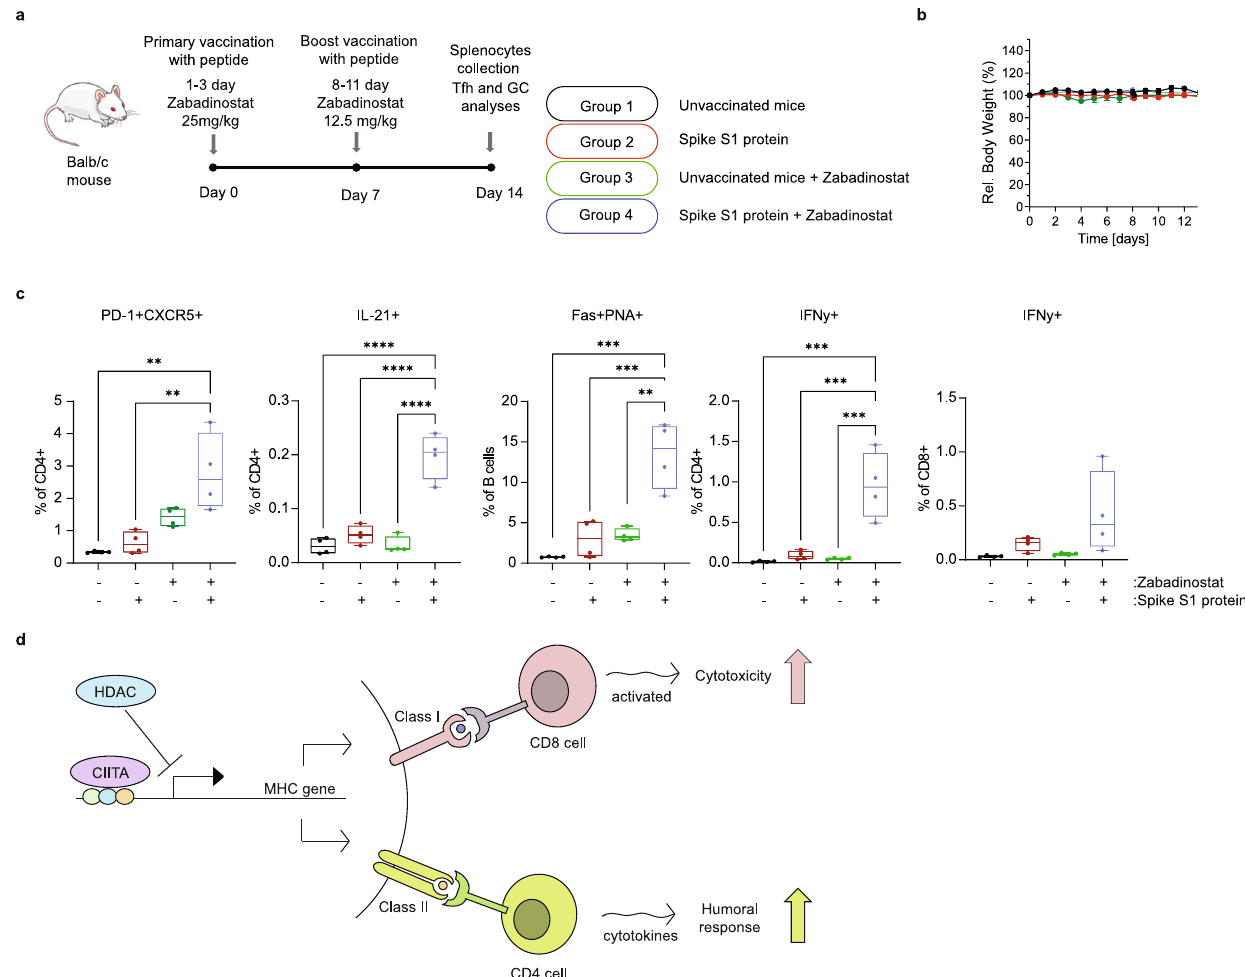
Fig. 7 Zabadinostat augments the level of GC B cells through modulating the activity of Tfh cells. a Schematic representation of the immunogenicity experiment with zabadinostat and spike S1 protein. Balb/c mice were treated with orally administrated zabadinostat at 25 mg/kg (days 1 – 3) or 12.5 mg/kg (days 8 – 11), and intravenous spike S1 protein (10 µ g) (days 0 and 7) with respect to vehicle-only control; splenocytes were collected at day 14; b relative body weight representation of treated and non-treated mice; n = 4; results presented as mean values + / − SD; c follicular T-cell level (CD4 + PD- 1 + CXCR5 + positive T cells), germinal centre B cells (Fas + PNA + positive B cells) and intracellular cytokine IL-21 (in CD4-positive T cells), IFNy (in CD4 and CD8-positive T cells) secretion measurements by fl ow cytometry; n = 4; results presented as mean values + / − SD; one-way ANOVA. d Model describing the effect of zabadinostat in regulating the adaptive immune response. It is proposed that inhibition of histone deacetylase induces both cellular and humoral immune responses by increasing antigen presentation (e.g., by dendritic cells), activating T and B cells and increasing germinal centre B cells (stimulated by follicular T cells), which coincides with elevated the MHC class I and II